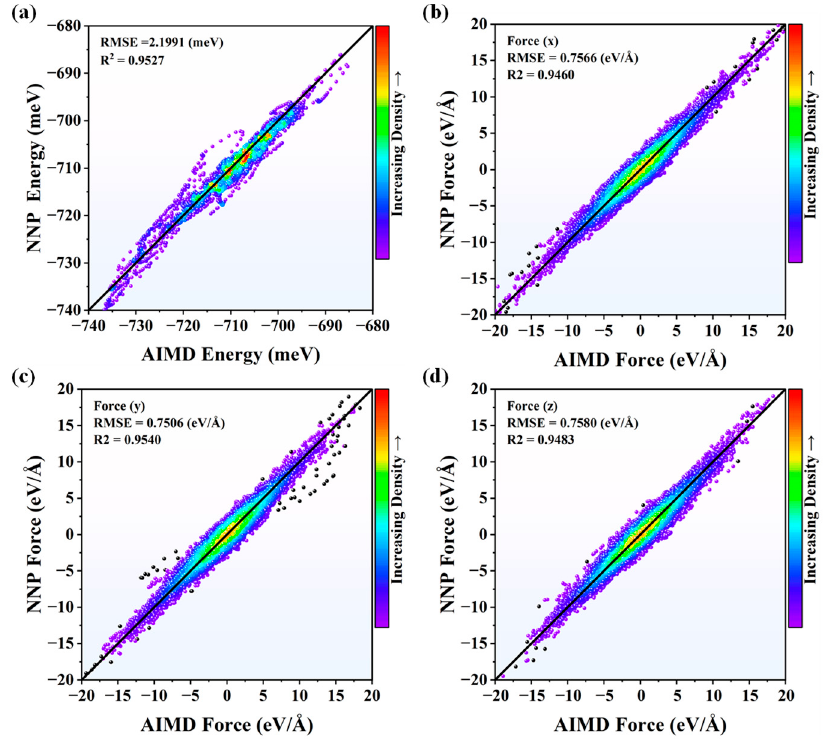
Figure 2. The comparisons of ( a ) energies and ( b – d ) forces from NNP and AIMD for Si 3 N 4 at 3000 K in x , y , and z directions.